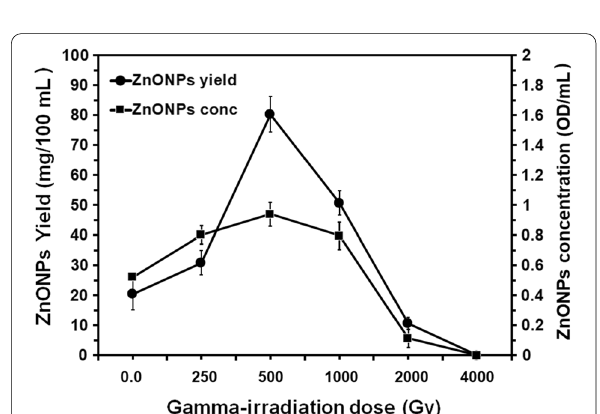
Fig. 5 Effect of several gamma‑irradiation doses on the production of ZnONPs synthesized by the fungus A. tenuissima . All data are shown as the mean SD of triplicate measurements from three ± independent experiments